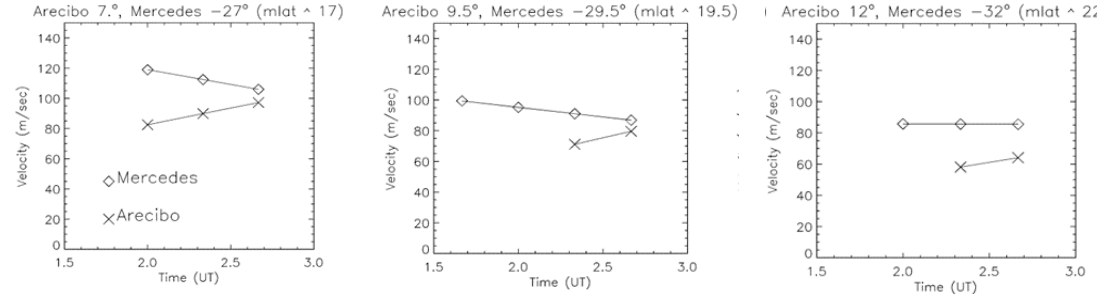
Figure 8. Example of velocities obtained on 27 February 2011 for depletions at different latitudes: 17° magnetic latitude ( left) , 19.5° magnetic latitude ( center ), and 22° magnetic latitude ( right ). Mercedes values are consistently higher than the ones measured at Arecibo.